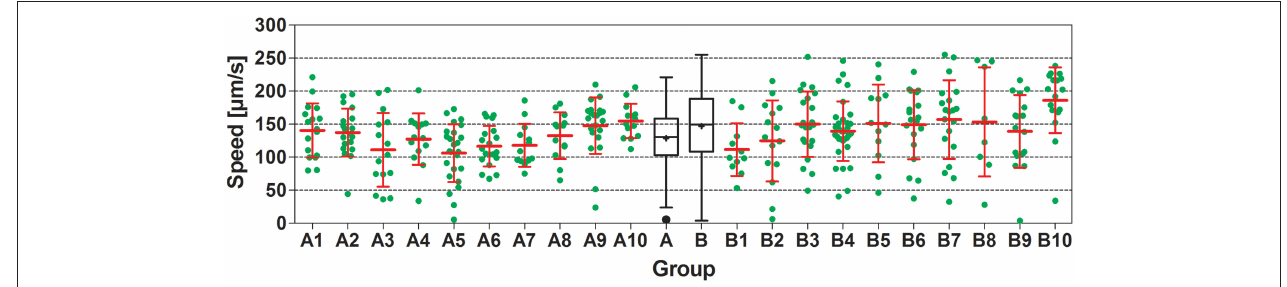
FIGURE 3 | Speed of locomotion of N2 (wild type) C. elegans on NGM agar plates with an E. coli lawn and on plates with no lawn. Groups A1–A10 and B1–B10 show individual data (green dots) and mean ± standard deviation (red lines) of speed of locomotion of N2 worms on 10 plates with an E. coli lawn (Groups A1–A10) and on 10 plates with no lawn (Groups B1–B10). Groups A and B show Tukey boxplots of the speed of locomotion of all worms on plates with an E. coli lawn (Group A) and of all worms on plates with no lawn (Group B). Nested ANOVA showed a statistically significant difference between worms on plates with an E. coli lawn and worms on plates with no lawn ( p = 0.049) as well as a statistically significant effect among plates ( p = 0.001; see also Table 2 ).